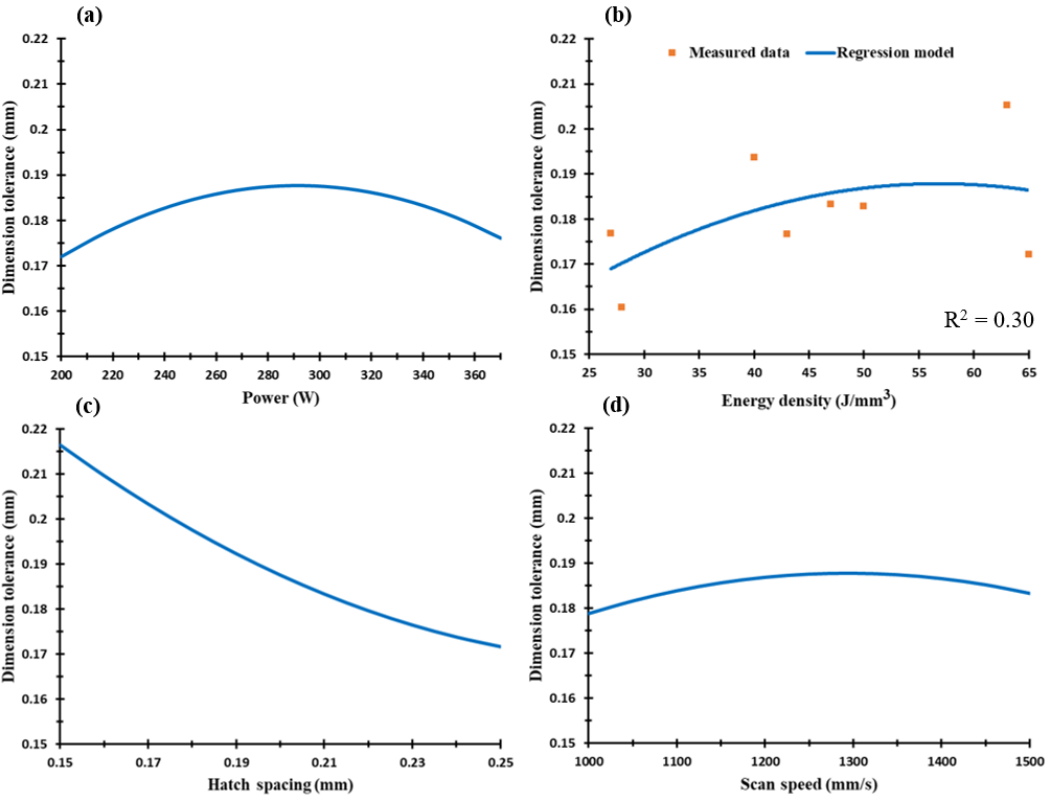
Figure 14. Dimension tolerance of the as-built AlSi10Mg samples vs. ( a ) laser power (W), ( b ) energy density (J/mm 3 ), ( c ) hatch spacing (mm), and ( d ) scan speed